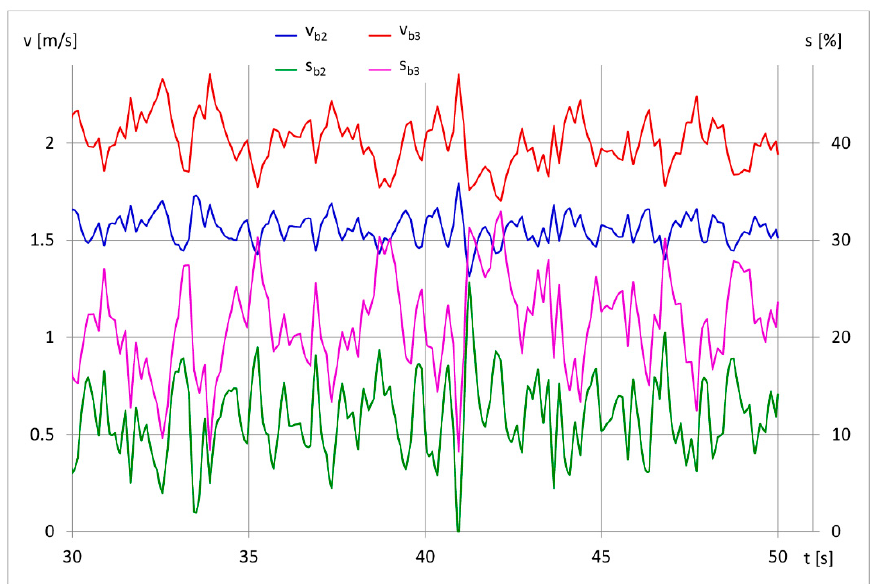
Figure 10. Changes in velocity of the unit v b and slip of drive wheels of the tractor s b , respectively, in the second gear ( v b 2 , s b 2 ) and in the third gear ( v b 3 , s b 3 ); soil profile—loamy sand, and cutting depth setting a nS 2 = 0.19 m.